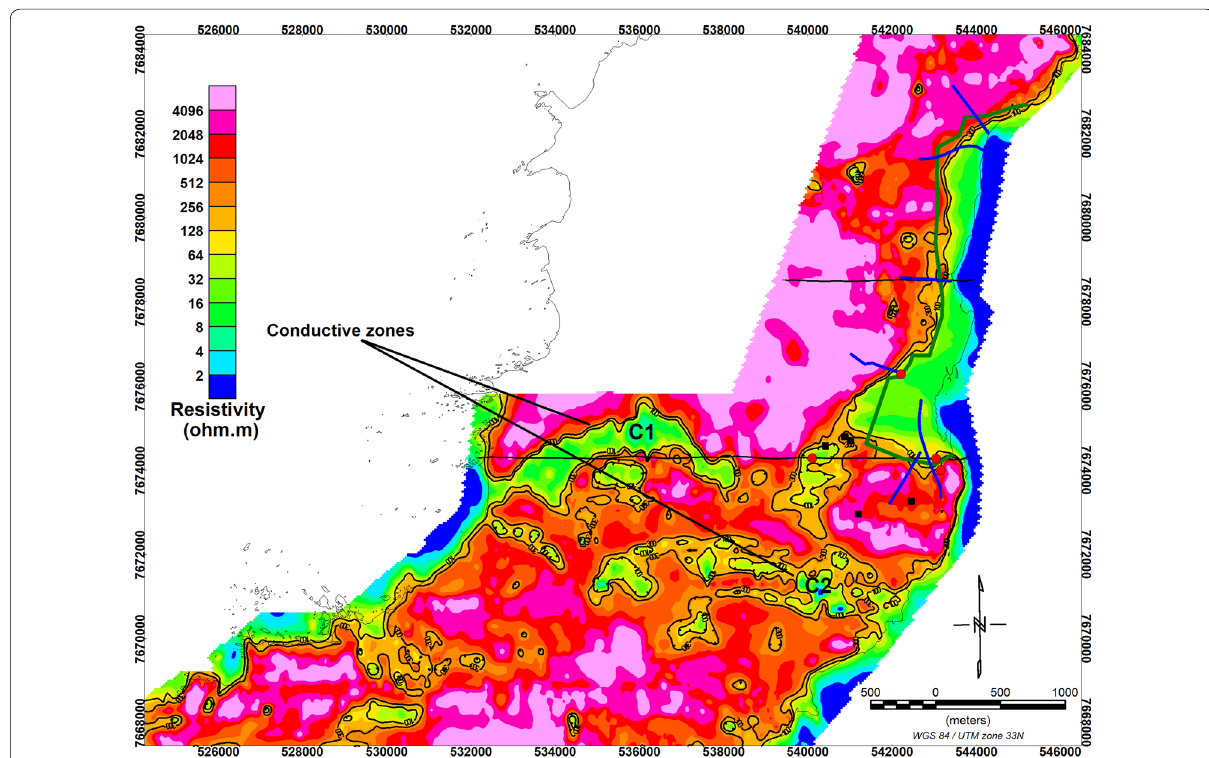
Fig. 8 HEM resistivity slice at 76 m depth below the surface with 100 and 300 Ωm resistivity contours (thin black lines). Ramså Basin boundary (green line) borehole locations (red circles), outcrop observations (black squares) and ERT lines (blue line) are also shown. Two conductive areas are marked as C 1 and C